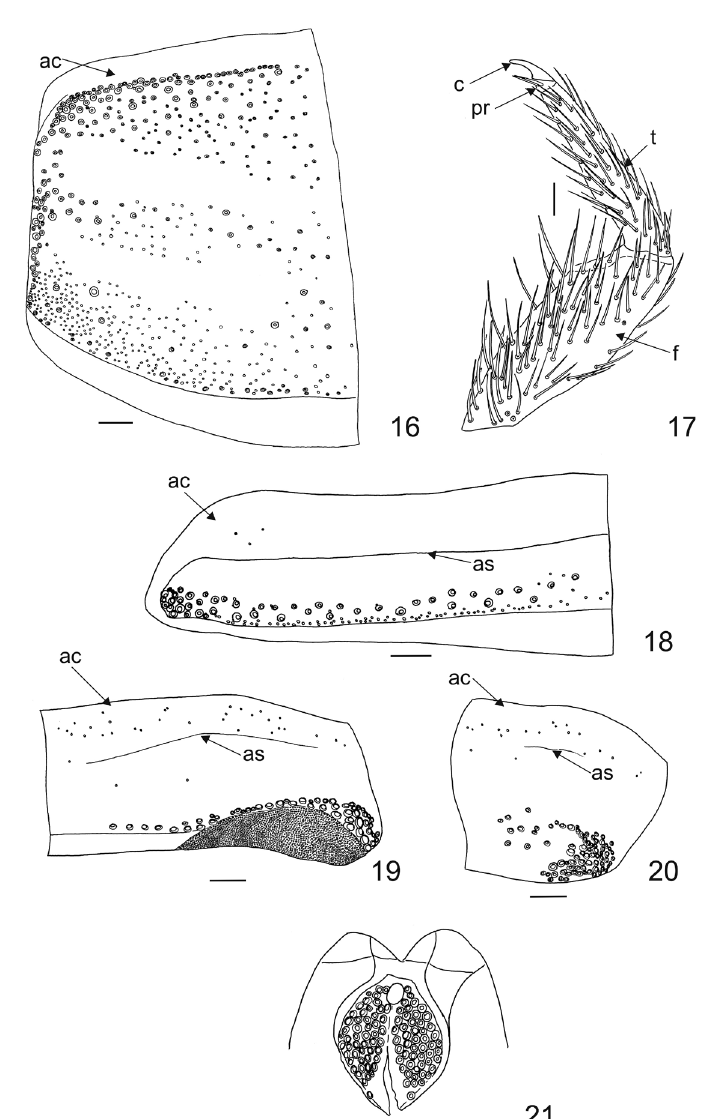
Figures 16–21. Mature larva of Ctesias (s. str.) serra (Fabricius, 1792). 16 Pronotum (dorsal, left half, de- nuded; large circles represent points of insertion of large spicisetae, small circles along the suture represent points of insertion of hastisetae) 17 Right protosternal leg (dorsal) 18 Abdominal tergum I (dorsal, left half, denuded; large circles represent points of insertion of large spicisetae, small circles represent points of insertion of hastisetae) 19 Abdominal tergum VII (dorsal, right half, denuded; large circles represent points of insertion of large spicisetae, small circles along the suture represent points of insertion of short setae, small circles below large circles represents points of insertions of hastisetae) 20 Abdominal tergum VIII (dorsal, right half, denuded; large circles represent points of insertion of large spicisetae, small circles along the suture represent points of insertion of short setae) 21 Abdominal tergum IX (dorsal, denuded; circles represent points of insertion of large spicisetae). Scale bars: 0.1